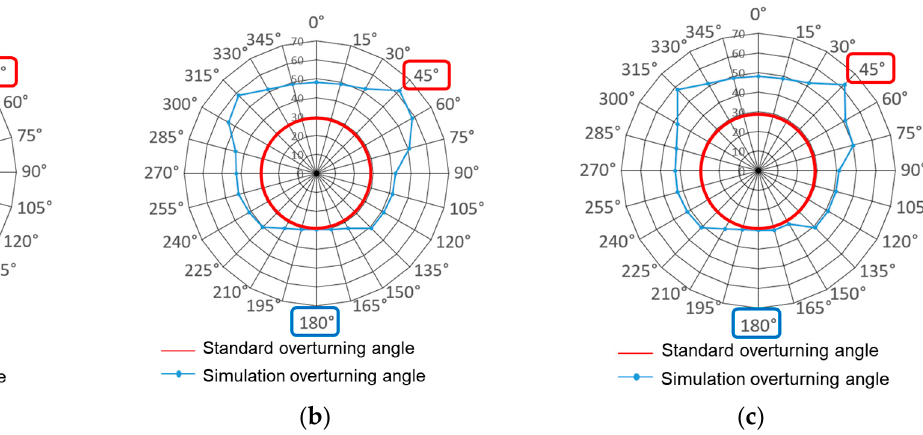
Figure 11. The rollover angles for the attached weights at the center of the radish harvester: ( a ) 50 kg, ( b ) 100 kg, and ( c ) 150 kg.